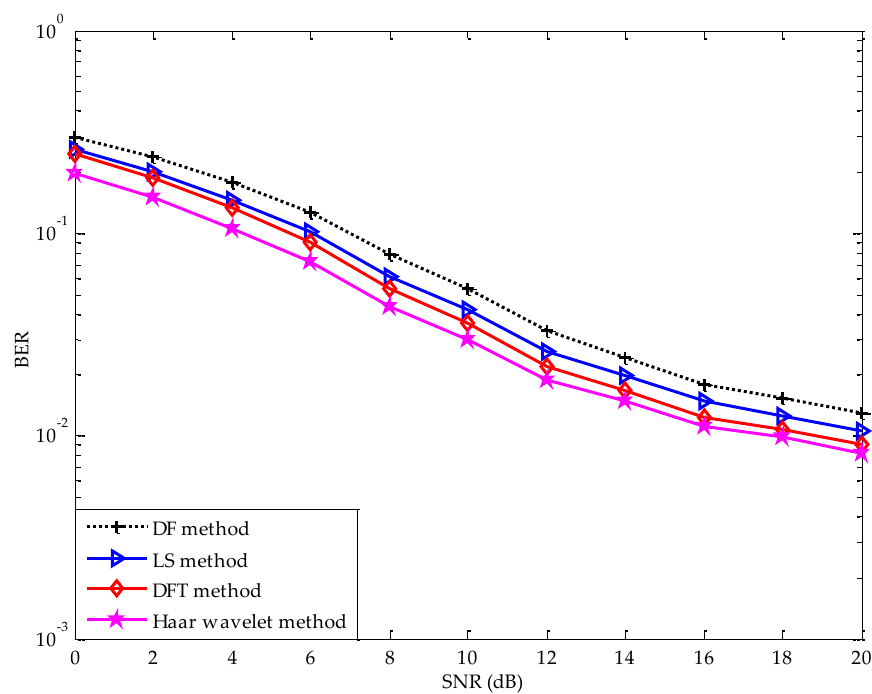
Figure 11. BER performance with QPSK modulated CP-OFDM and wavelet-OFDM systems under CDT6 channel with Doppler spread 20Hz.